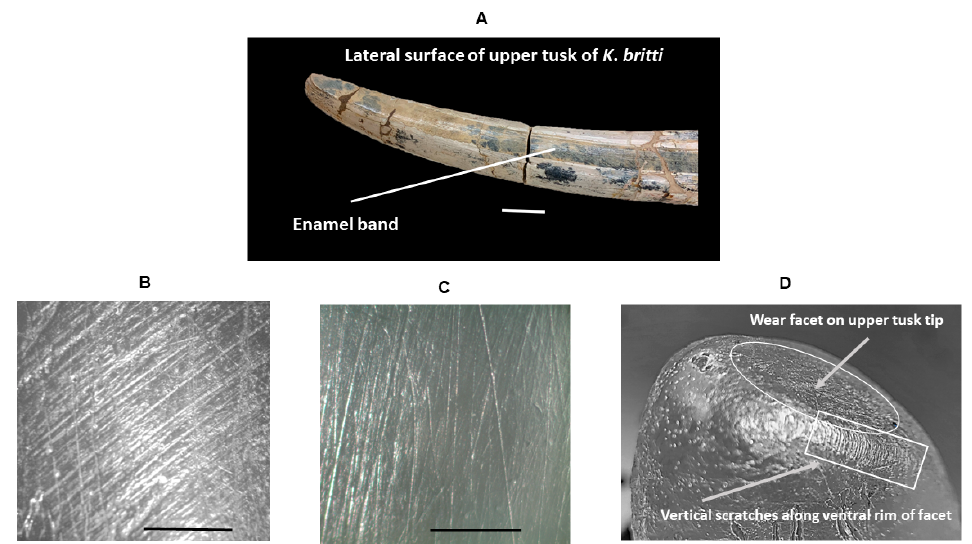
Figure 7. Enamel surfaces of upper shovel- tusker tusks. ( A ). Lateral enamel band found on shovel- tusker upper tusks (scale bar is 100 mm); ( B ). Ventral surface of right upper tusk of K . britti (UF 69998 at 50×). ( C ). Ventral surface of upper right tusk of A . floridanus (UF 212305 at 50×). 7D. Vertical scratches along the ventral rim of a wear facet on the upper right tusk tip of A . floridanus (UF 212305) The tusk tip in ( D ) is not magnified in the photo.